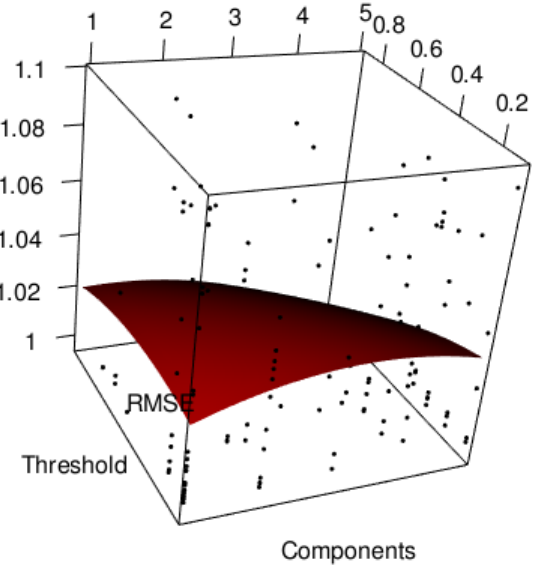
Figure 3. The RMSE on the test data measuring the prediction capability of CO 2 yield with cube mor- phology is plotted against the number of PLS W V components and the threshold. The fitted response surface indicates that as the number of components and threshold level increase, the RMSE